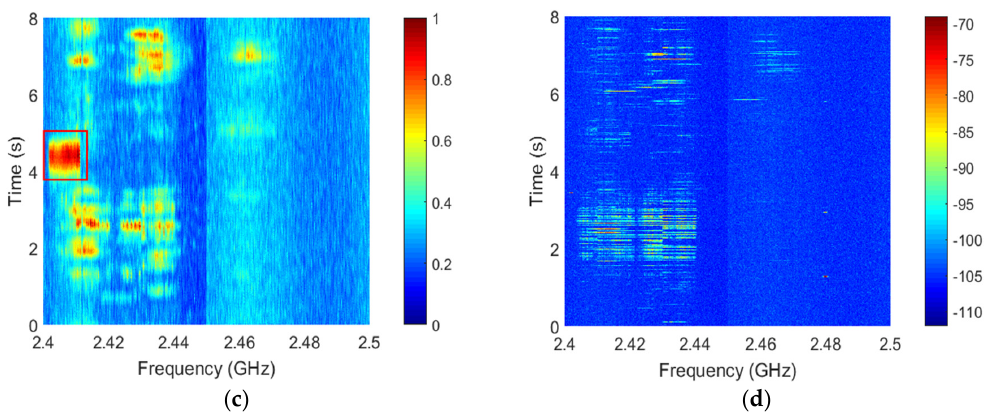
Figure 3. ( a ) The time–frequency matrix in an ideal environment with the unmanned aerial vehicle (UAV) present, ( b ) the matrix in a real-world environment with the UAV present, ( c ) the matrix after filtering and normalization in a real-world environment with the UAV present, and ( d ) the matrix in a real-world environment with no UAV present.